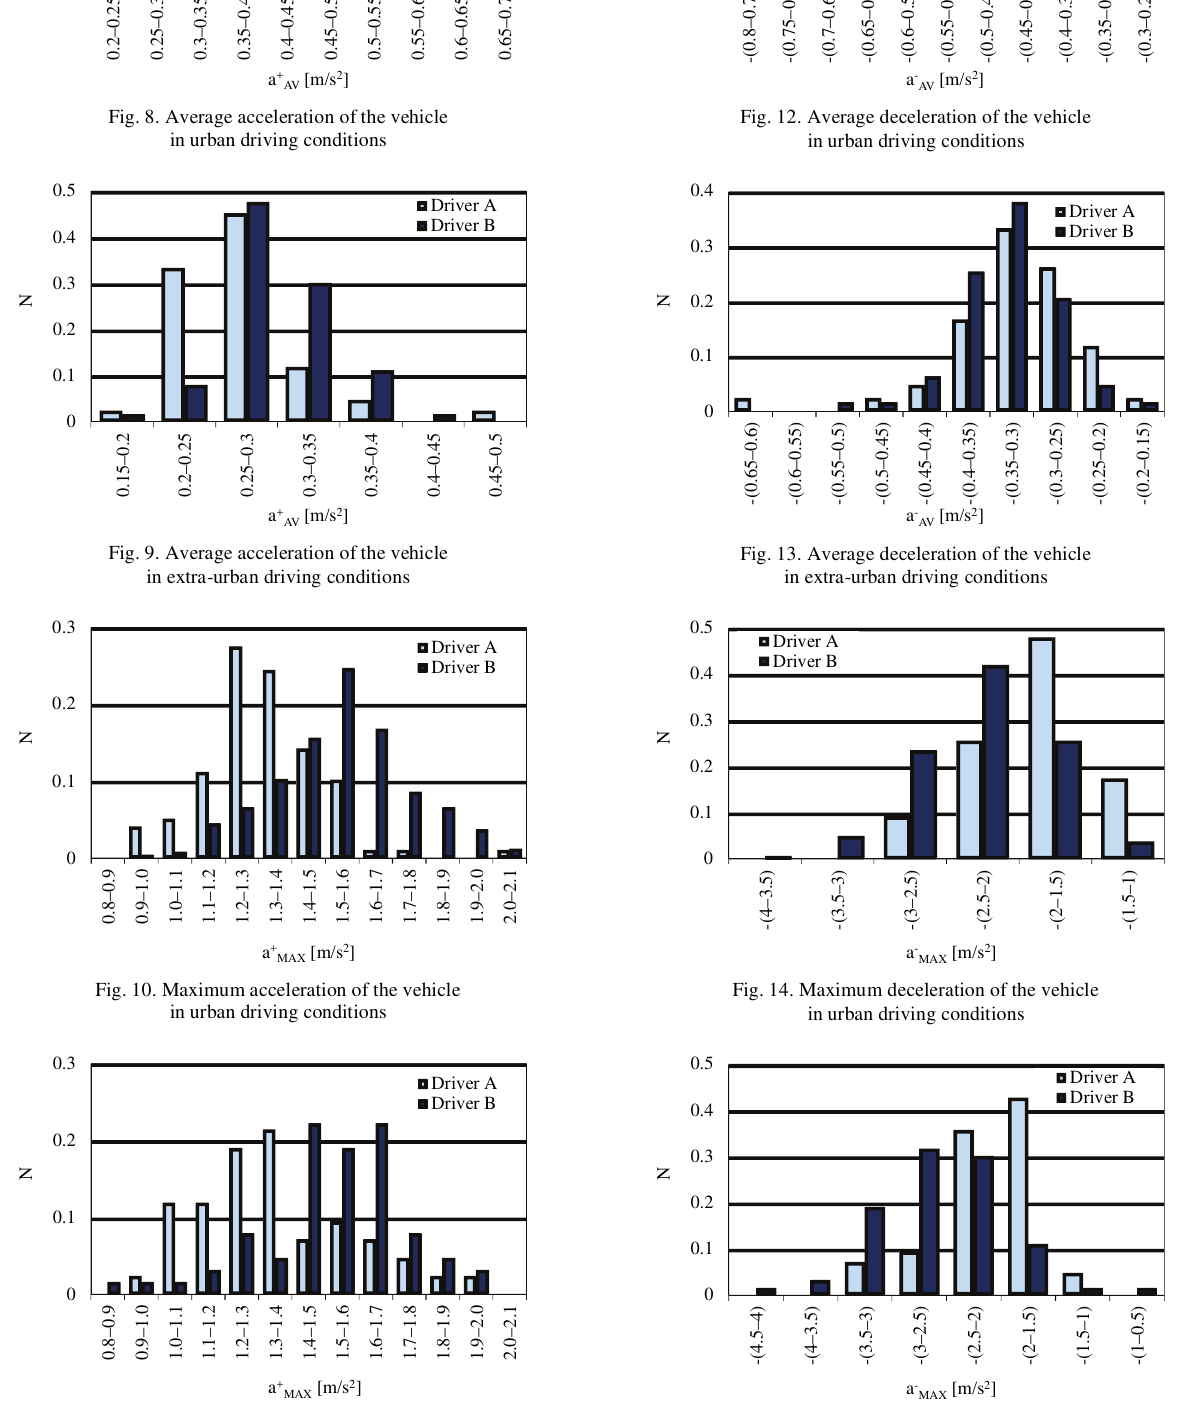
Fig. 11. Maximum acceleration of the vehicle in extra-urban driving conditions